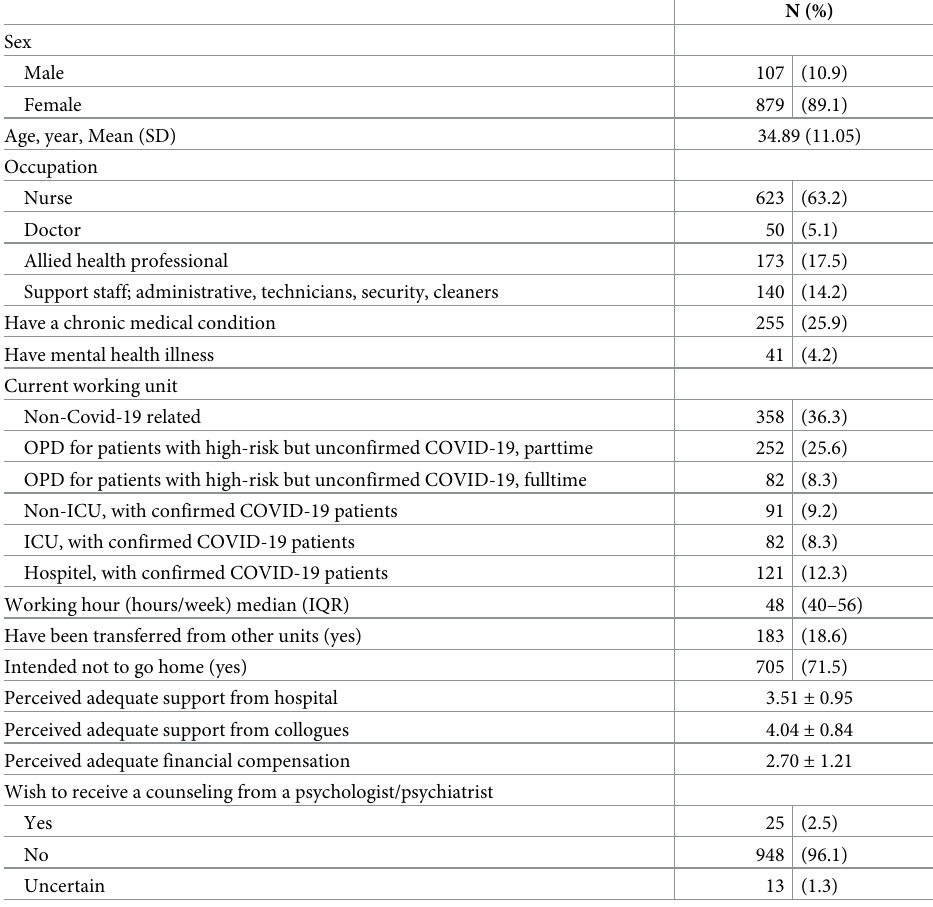
Table 1. Demographic, work characteristics, and perceived support (n =